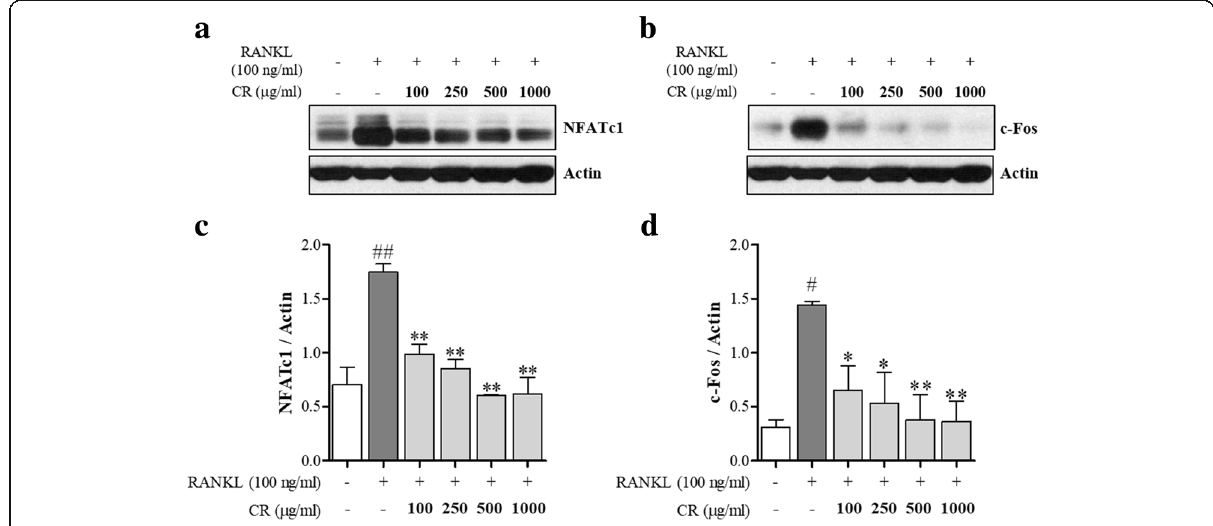
Fig. 5 Effect of CR on the activation of NFATc1 and c-Fos by RANKL. a NFATc1 and b c-Fos protein expressions were determined by western blot. Expressions of c NFATc1 and d c-Fos were normalized to actin. Columns and error bars represent the mean ± S. E of three independent experiments. ## p < 0.01, # p < 0.05 compared with normal and ** p < 0.01, * p < 0.05 compared with the control